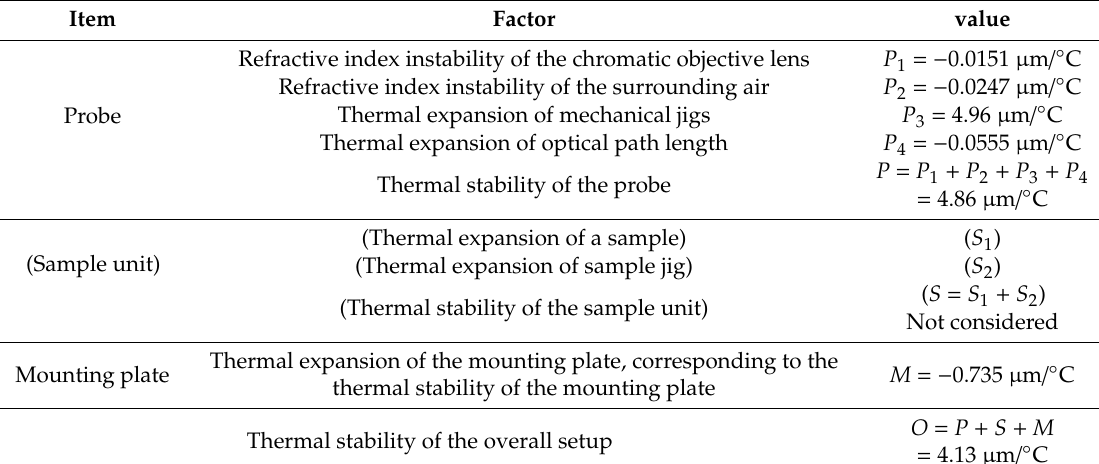
Table 3. Summary of the contribution of each factor on the overall thermal stability of the